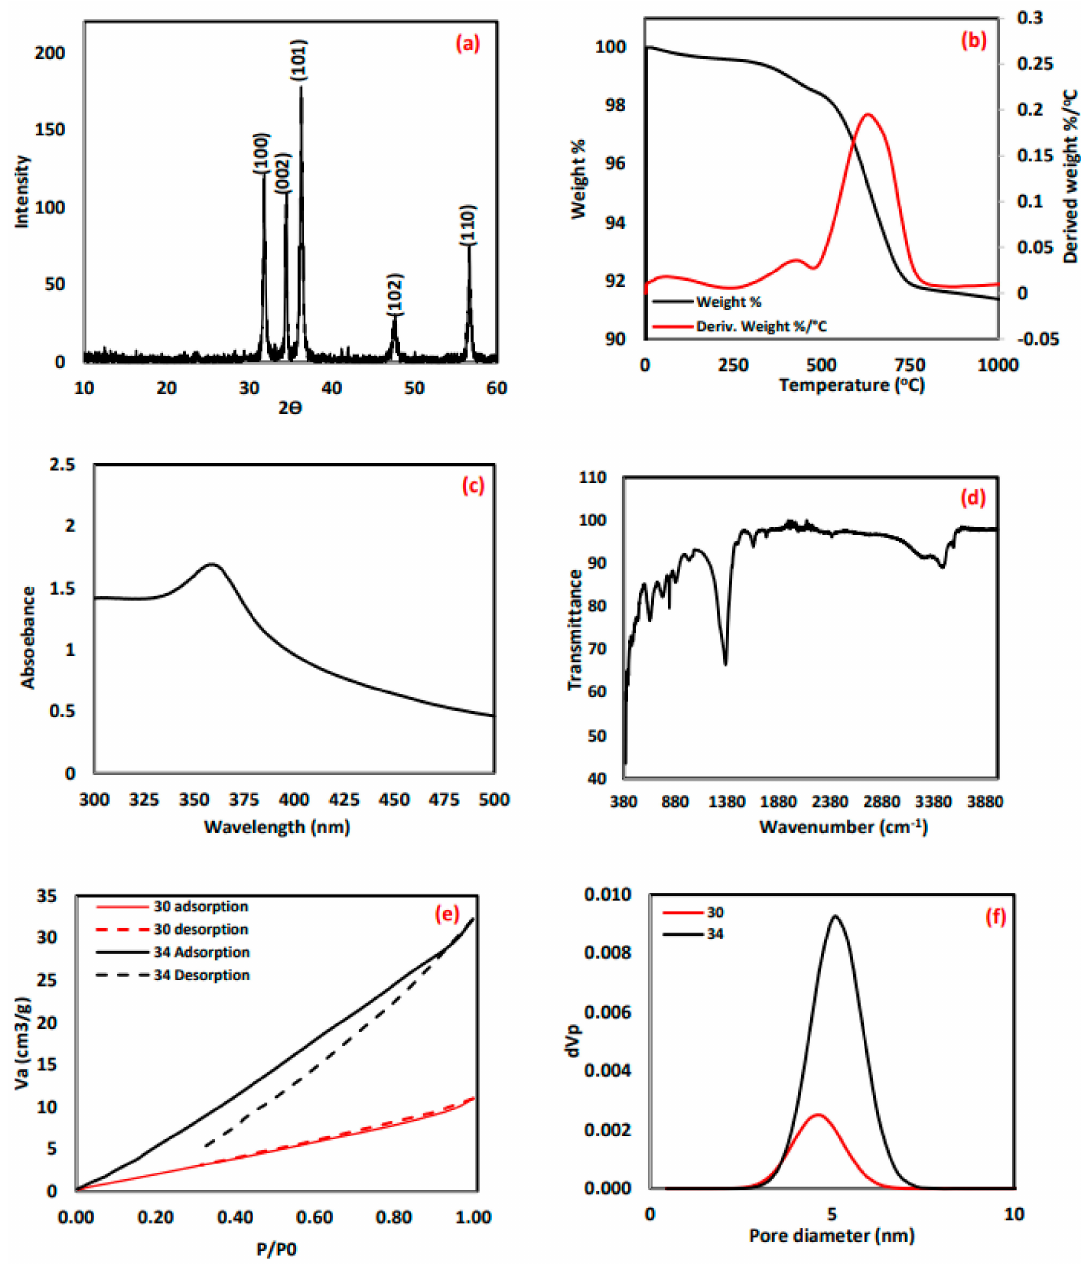
Figure 1. ( a ) XRD pattern of sample 31 prepared under the conditions of C = 0.2 M, pH = 7, T = 100 ◦ C, and t = 1 h. ( b ) Thermal gravimetric analysis (TGA) and DTA analysis results of sample 10 prepared under the conditions of C = 0.4 M, pH = 7, T = 100 ◦ C, and t = 2 h. ( c ) UV-VIS spectrum of sample 1 prepared under the conditions of C = 0.3 M, pH = 11, T = 150 ◦ C, and t = 1.5 h. ( d ) FTIR spectrum for the range of 4000–400 cm − 1 of sample 1 prepared under the conditions of C = 0.2 M, pH = 7, T = 100 ◦ C, and t = 1 h. ( e ) Nitrogen adsorption desorption isotherms for samples 30 and 34. ( f ) Pore size distributions for samples 30 and